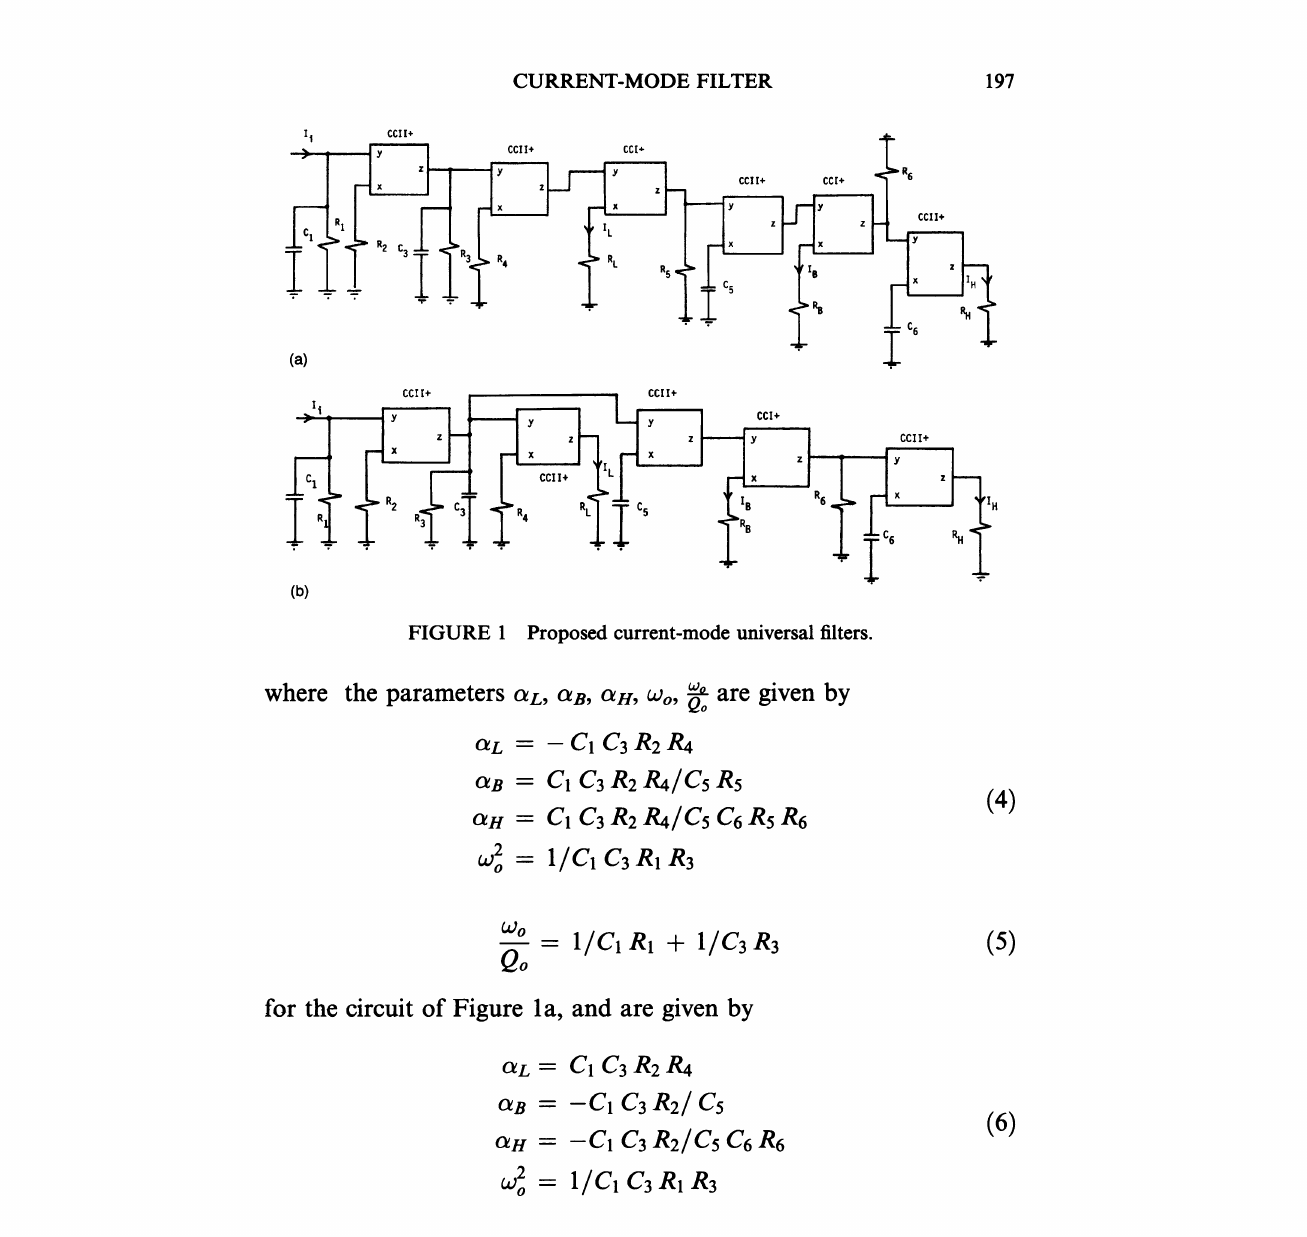
FIGURE Proposed current-mode universal